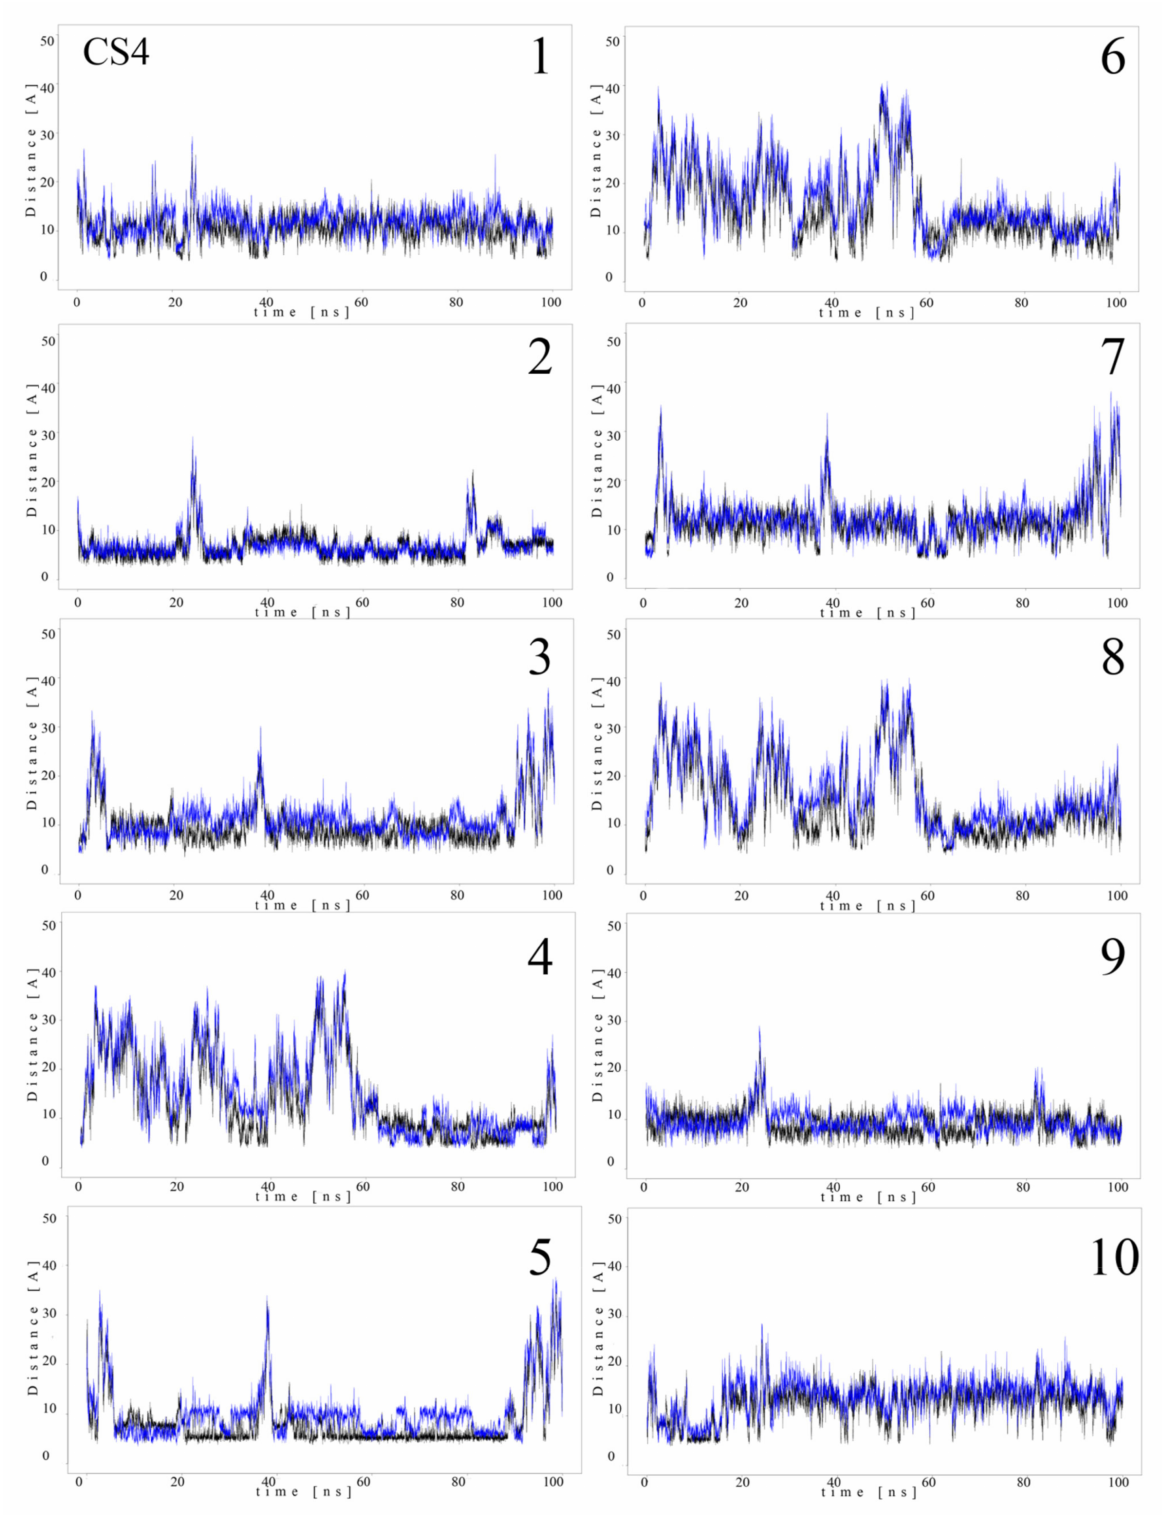
Figure 6. Distances (Å) between CS4 dp10 sulfate groups (corresponding sulfur atom), the carboxylate group (corresponding carbon atom) and one of the nitrogen atoms from the dimethylamino moieties of MB molecules ( 1 – 10 ) during MD (black, N -acetylgalactosamine-4-sulfates; blue, carboxylate